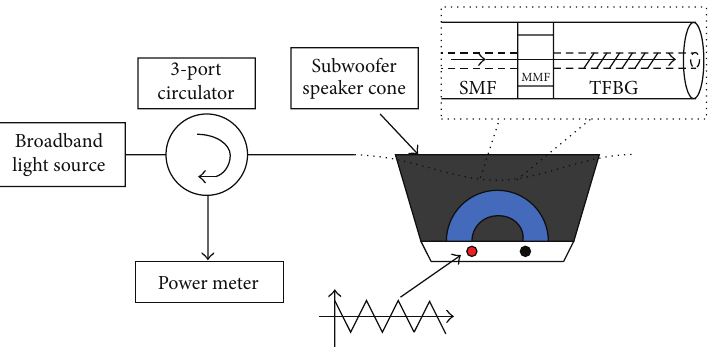
Figure 1: Sensing scheme based on the TFBG for vibration measurement. The inset shows the schematic diagram of the sensing head.